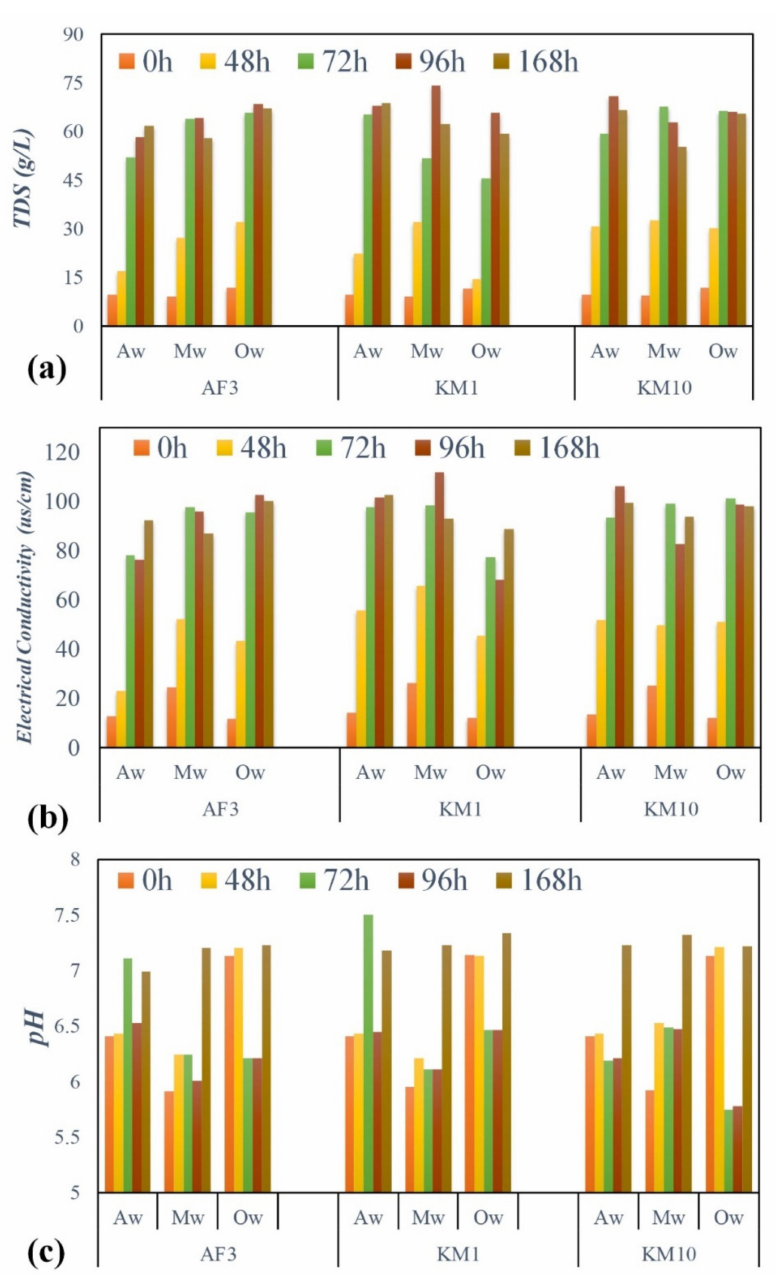
Figure 6. Variation in Total Dissolved Solids ( a ), Electrical conductivity ( b ) and pH ( c ) of the waste samples observed during aerobic biodegradation of the waste slurry by different bacterial